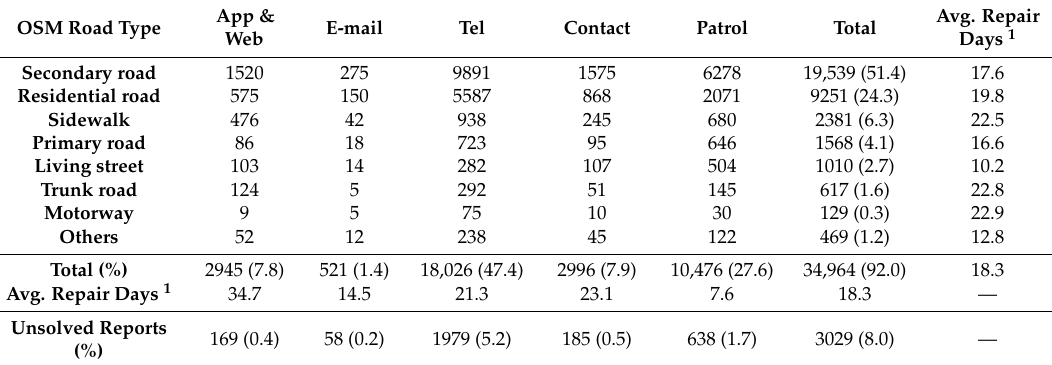
Table 3. Average number of days needed to process road issues (N = 37,993).